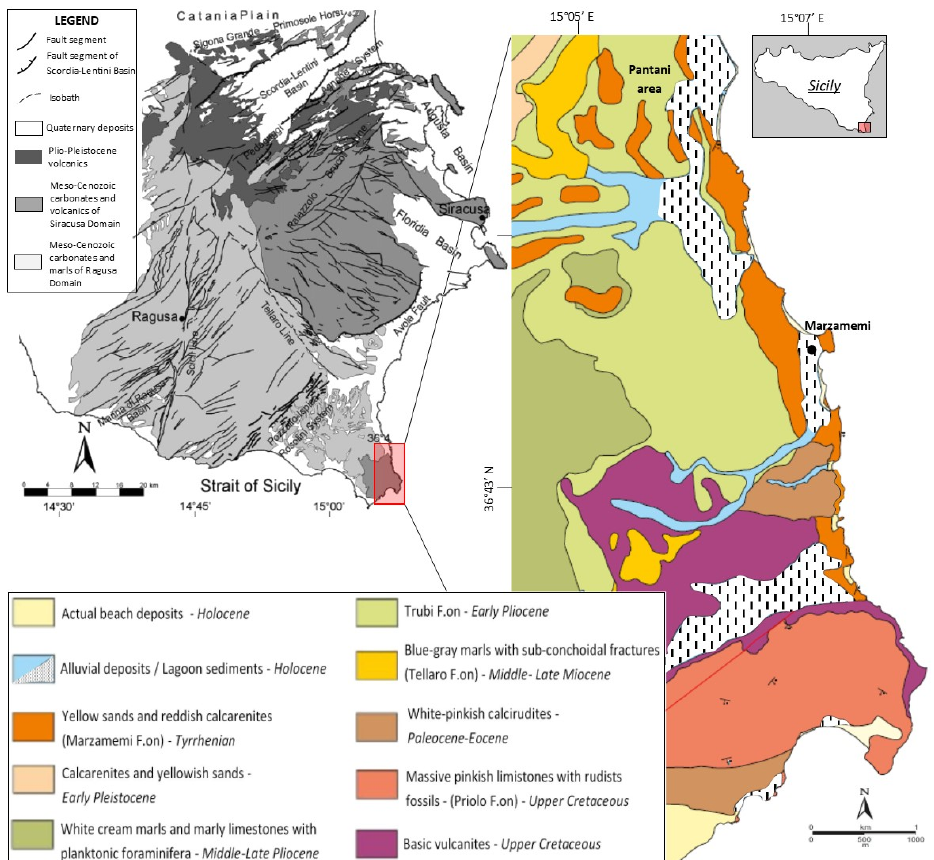
Figure 2. Schematic geological and structural map (WGS 84) of the Hyblean region (modified from [26]). The inset in red represents the location of Marzamemi (Syracuse, Sicily) with detail of the geological structure of the area (modified from [23]).